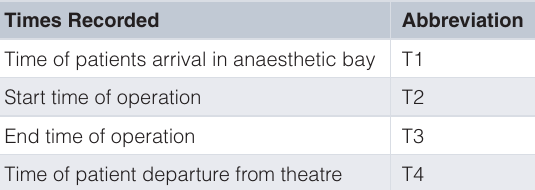
Table 1. Times extracted from Operating Room Management Information System (ORMIS) theatre management software (CSC) during the audit period, listing the various steps during a patient’s operative journey. Times Recorded